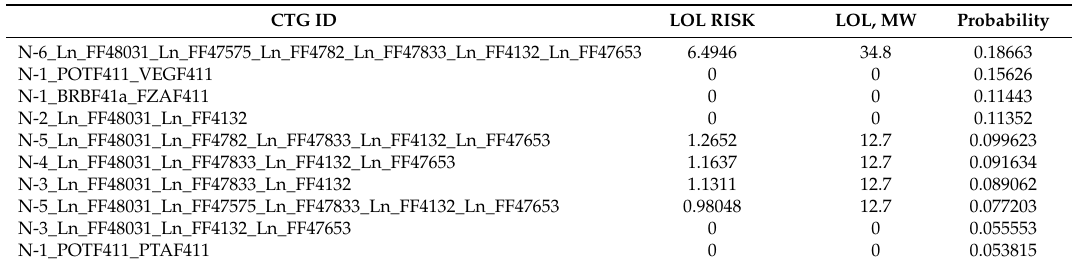
Table 5. Top 10 positions in the probability ranked list of contingencies—hour 15.